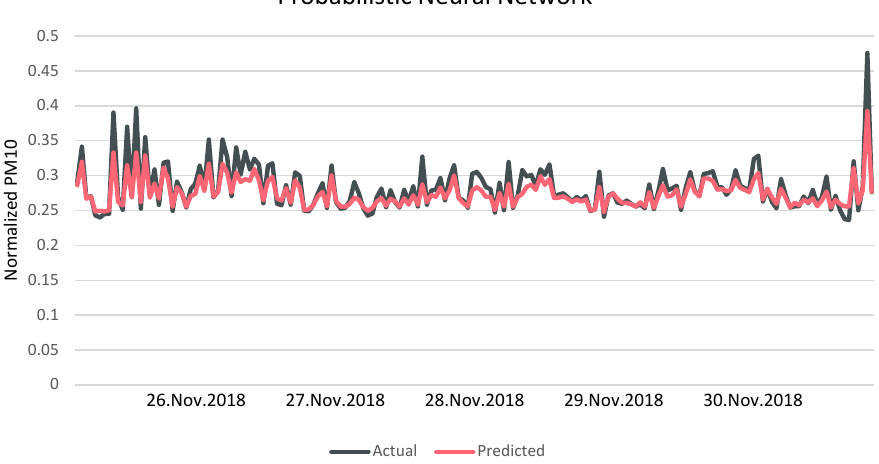
Figure 11. Comparison between the Probabilistic Neural Network (PNN) prediction and the test